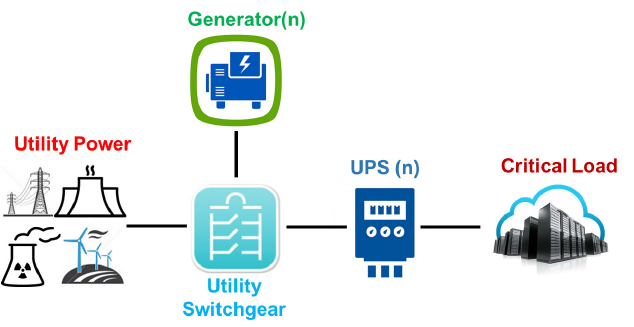
Figure 1. Tier I data center power